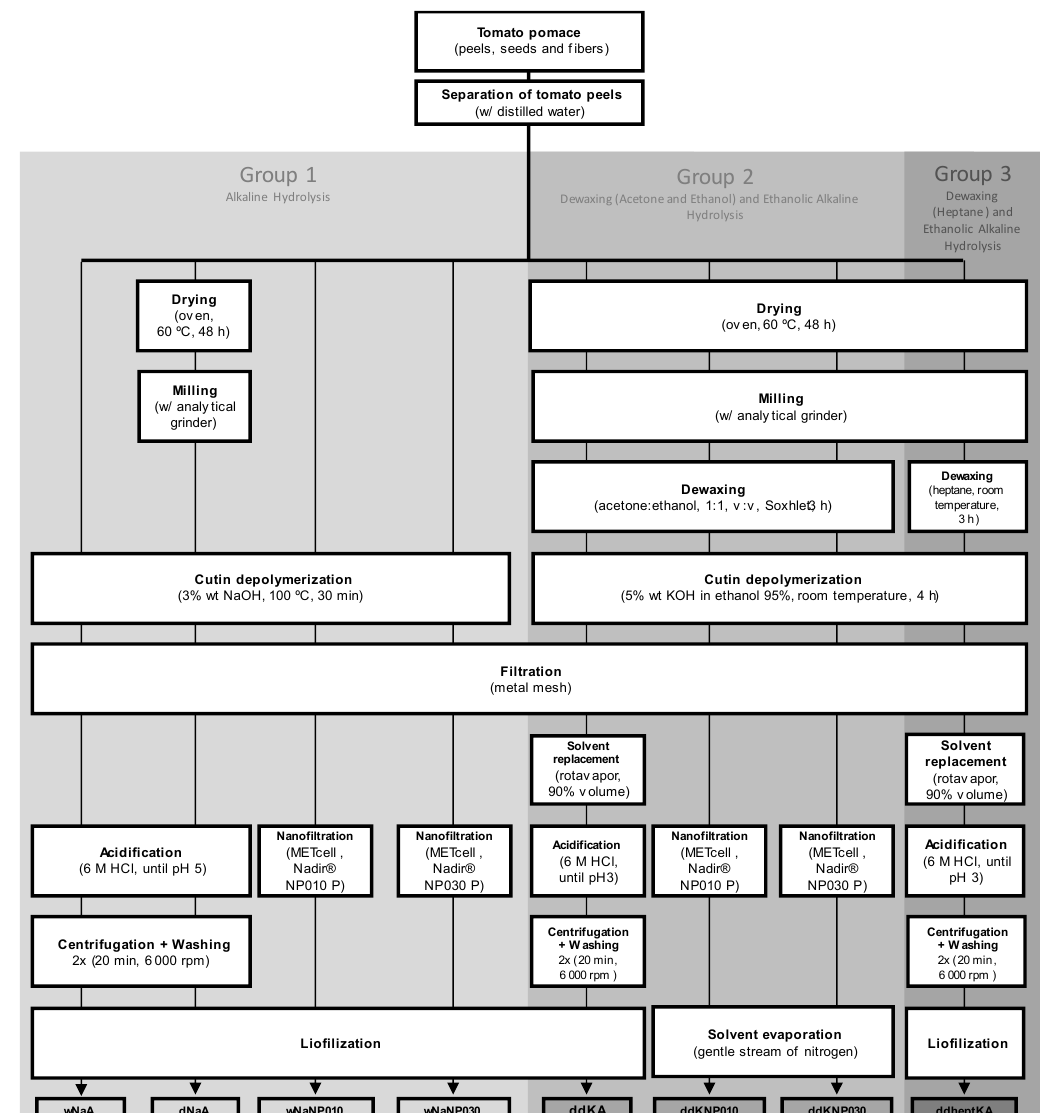
Figure 1. Flow diagram summarizing all the methods tested in this study to depolymerize and extract cutin. Group 1 Alkaline Hydrolysis : wNaA , wet tomato peels, depolymerization with NaOH, acidification; dNaA , dry tomato peels, depolymerization with NaOH, acidification; wNaNP010 , wet tomato peels, depolymerization with NaOH, processed with NP010; wNaNP030 , wet tomato peels, depolymerization with NaOH, processed with NP030. Group 2 Dewaxing (Acetone and Ethanol) and Ethanolic Alkaline Hydrolysis : ddKA , dry tomato peels, dewaxing with acetone and ethanol, depolymerization with KOH, acidification; ddKNP010 , dry tomato peels, dewaxing with acetone and ethanol, depolymerization with KOH, processed with NP010; ddKNP030 , dry tomato peels, dewaxing with acetone and ethanol, depolymerization with KOH, processed with NP030. Group 3 Dewaxing (Heptane) and Ethanolic Alkaline Hydrolysis : ddheptKA , dry tomato peels, dewaxing with heptane, depolymerization with KOH, acidification. Obs: For the sake of simplicity, not all processing steps are described in the legend, particularly: 1—after drying, there is a milling process; 2—after depolymerization, there is a filtration process; 3—after the acidification step, there is centrifugation and washing; 4—the final step is lyophilization, except during the processing sequence of Group 2, where membrane processing is the final